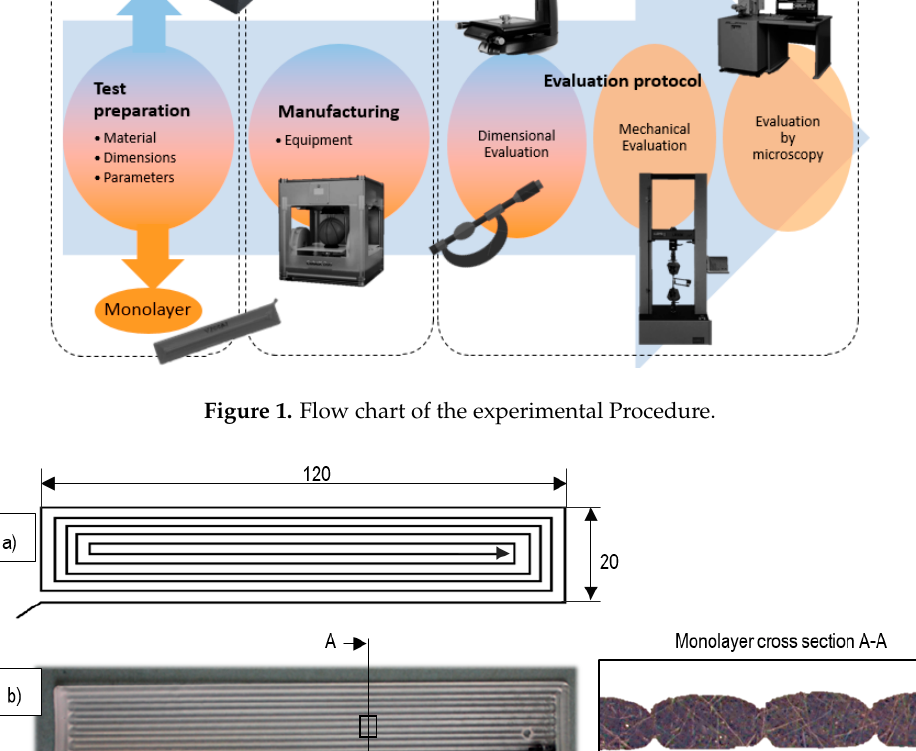
Figure 2. ( a ) Dimensions and trajectories used for monolayer samples [6]; ( b ) monolayer cross-sectional mesostructure.